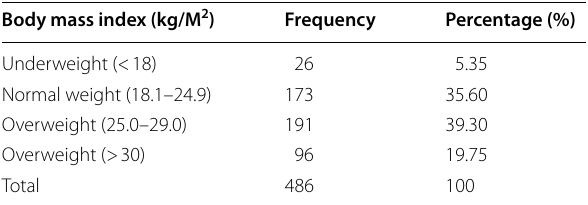
Table 1 Body weight of diabetic patients in Alimosho and Isolo General Hospitals, Lagos